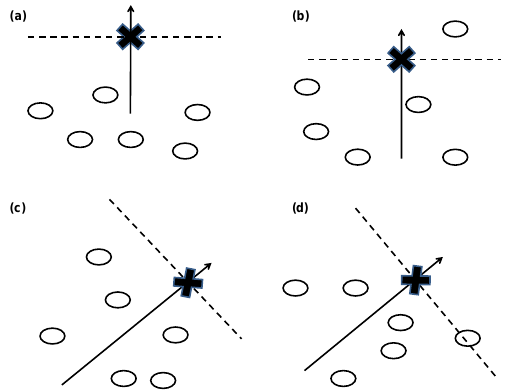
Figure 1. Front position of the initiator. To qualify as being at the front of the group, no group members (open ovals) must be posi- tioned (moved there or already be there during the initiation move- ment) at or in front of the imaginary line (dashed line) perpendicular to the initiator’s (cross) trajectory (arrow). (a, c) The initiator is at the front of the group. (b, d) Initiator is not at the front of the